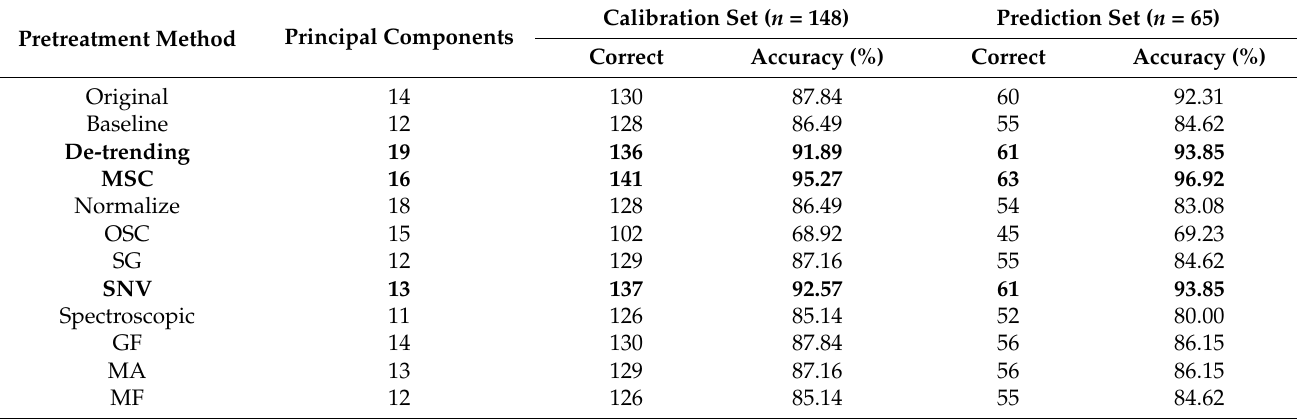
Table 3. Classification results of PLS-DA for the original and filtered